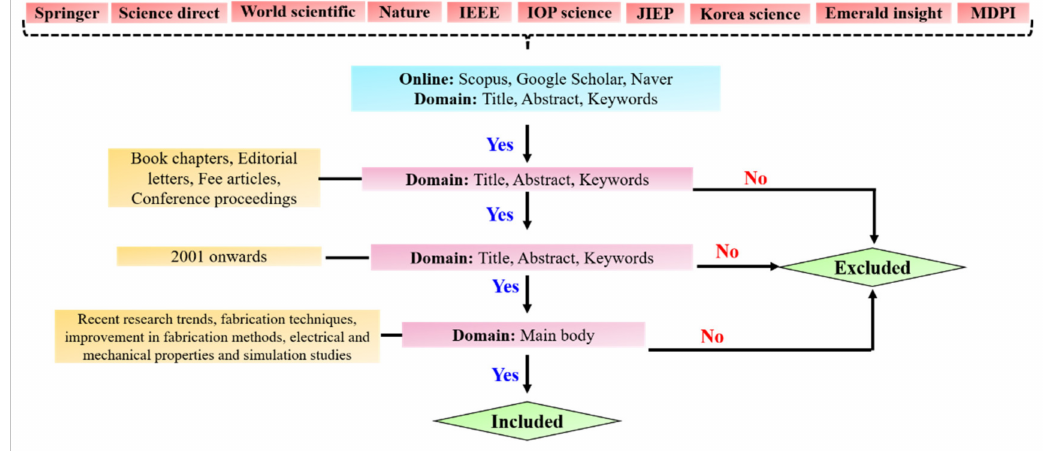
Figure 1. Literature review approach adopted in the present work.